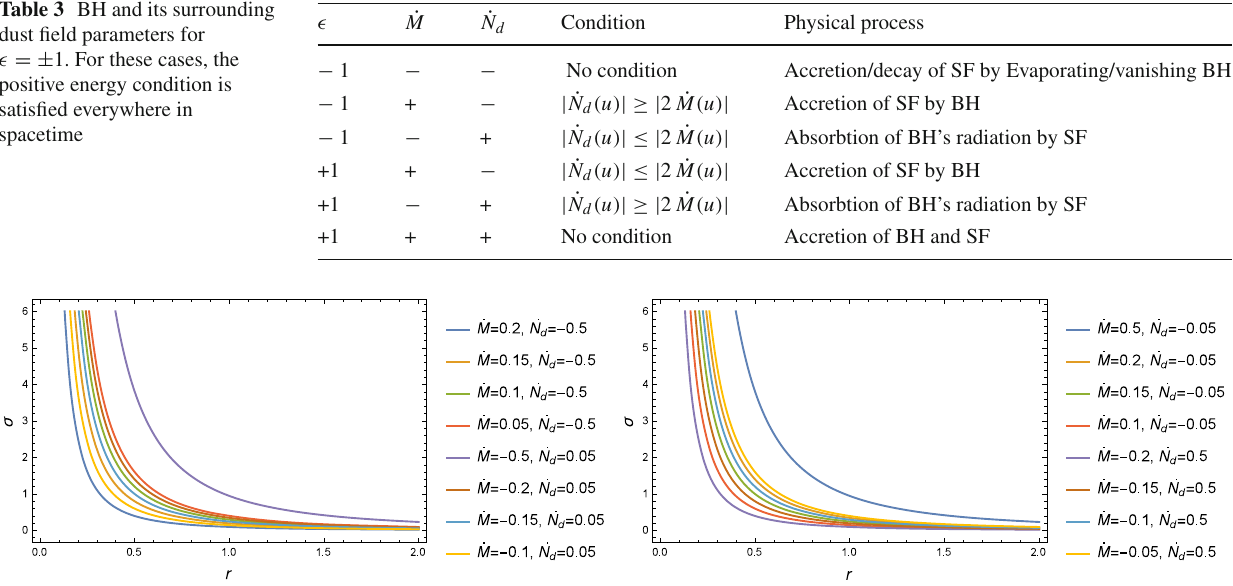
Fig. 2 Left figure: The radiation-accretion density σ versus the dis- tance r for some typical constant values of ˙ M and ˙ N d for (cid:5) = − 1 in the dust background. The four upper cases and the four lower cases corre- spond to the conditions | ˙ N d ( u ) | ≥ | 2 ˙ M ( u ) | and | ˙ N d ( u ) | ≤ | 2 ˙ M ( u ) | , respectively. By these conditions, it is clear that σ( r ) is a decreasing function but is positive, and consequently the positive energy condi- tion is satisfied everywhere in spacetime. Right figure: the radiation-